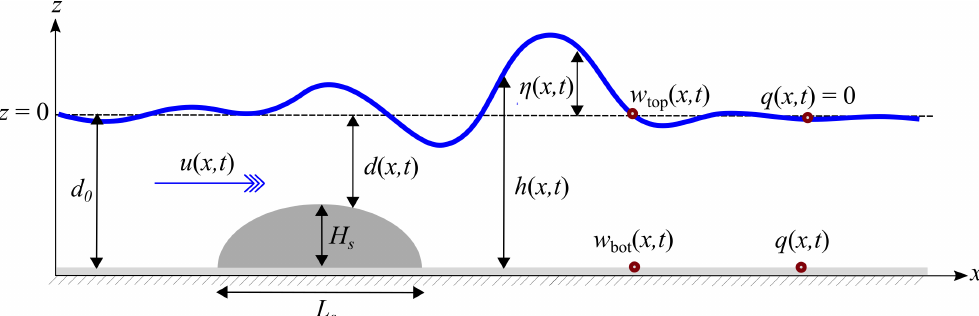
Figure 1. Variables in a one-layer non-hydrostatic